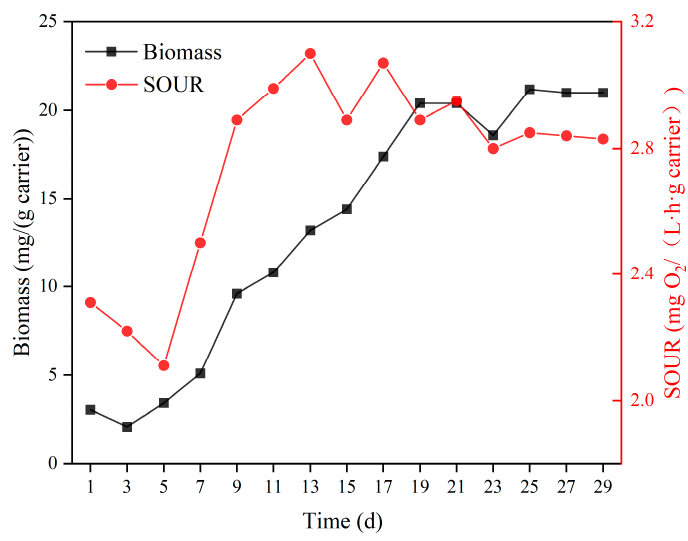
Figure 3. Variations of immobilized biomass and biological activity in the